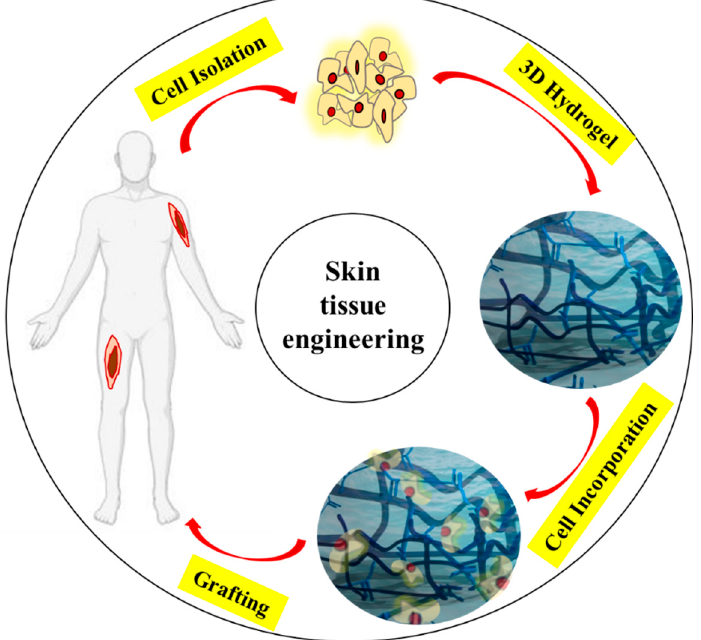
Figure 3. Schematic representing the preparation process of a cell-laden hydrogel in which cells from an isolated donor are placed and then cultured in a 3D hydrogel matrix and grafted to a skin defect as a skin substitute.